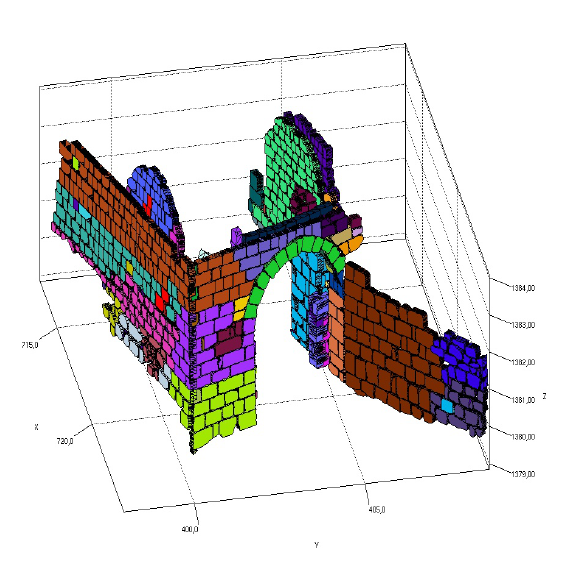
Figure 2. Stratigraphic units identified by their ashlar blocs when they are positive.